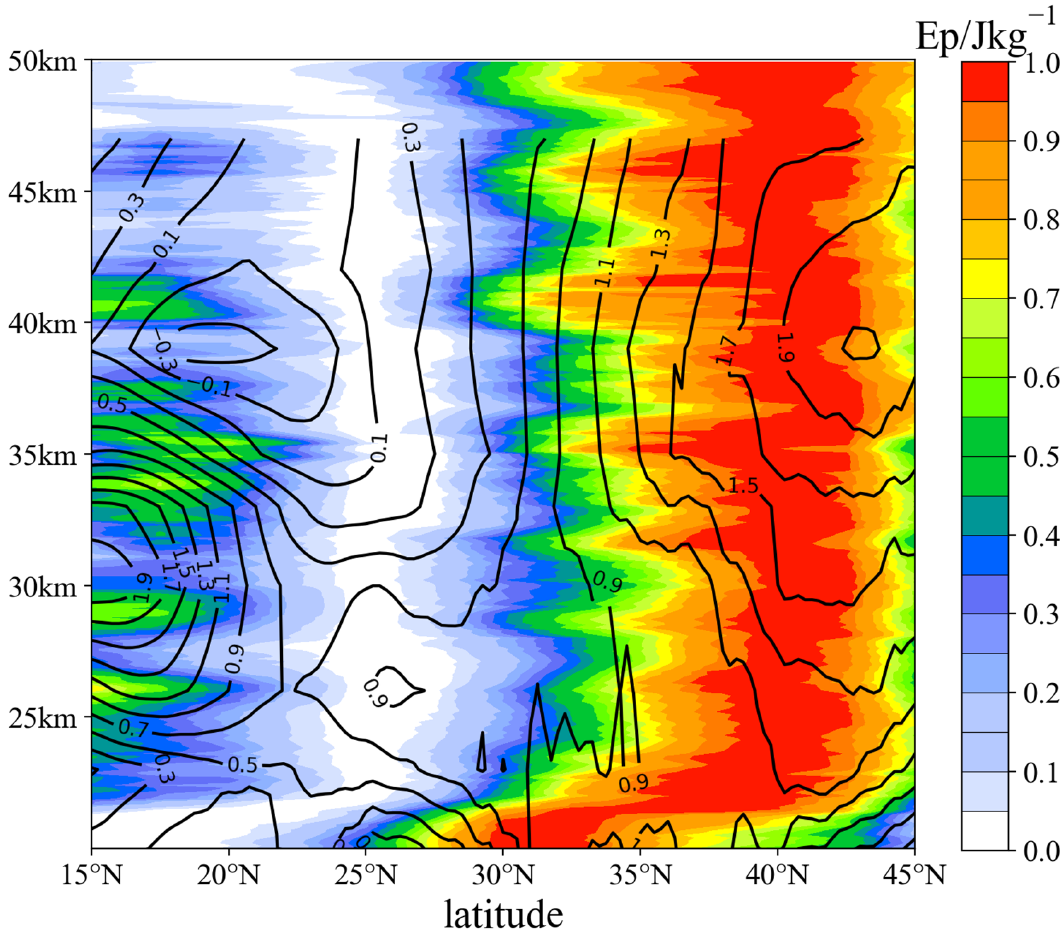
u y ∂ ∂ Figure 10. Seasonal mean ∂ u / ∂ y (contours, units: 10 − 5 /s) and normalized Ep distribution along Figure 10. Seasonal mean (contours, units: 10 − 5 /s) and normalized Ep distribution along 105 ◦ E ( ± 5 ◦ ) (shaded, units: Jkg − 1 105°E (±5°) (shaded, units: Jkg − 1 ).